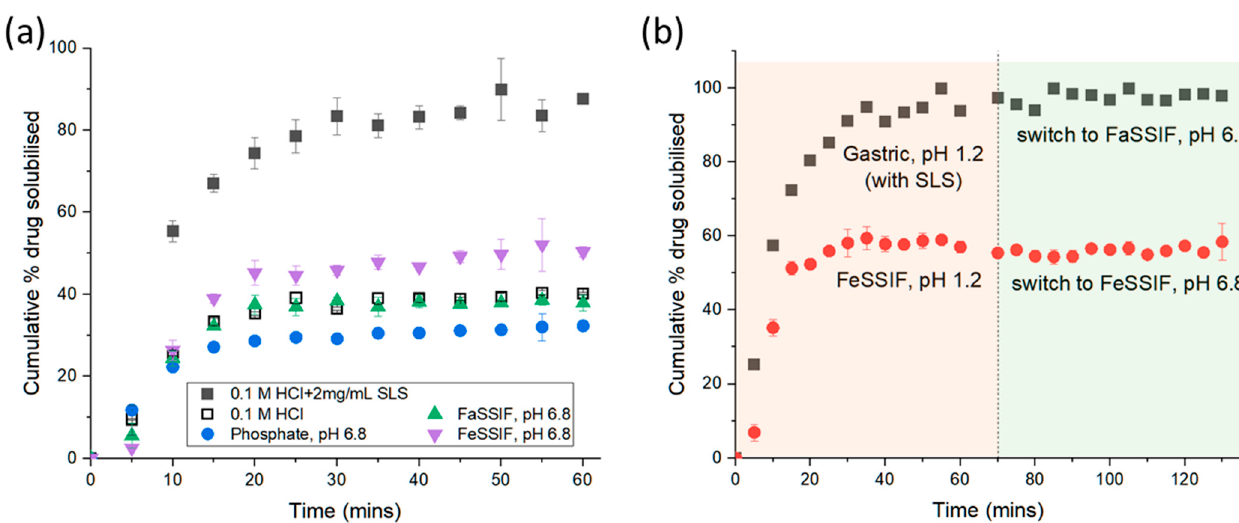
Figure 2. ( a ) Percentage of praziquantel dissolved during in vitro dissolution testing of 600 mg praziquantel Biltricide ® tablet in 900 mL of different dissolution media. Errors are standard deviation from n = 3 replicates. ( b ) Effects of pH switching on percent of drug solubilised. Table 1. Solubility of praziquantel in different dissolution media. Errors are standard deviation from n = 3 replicates.